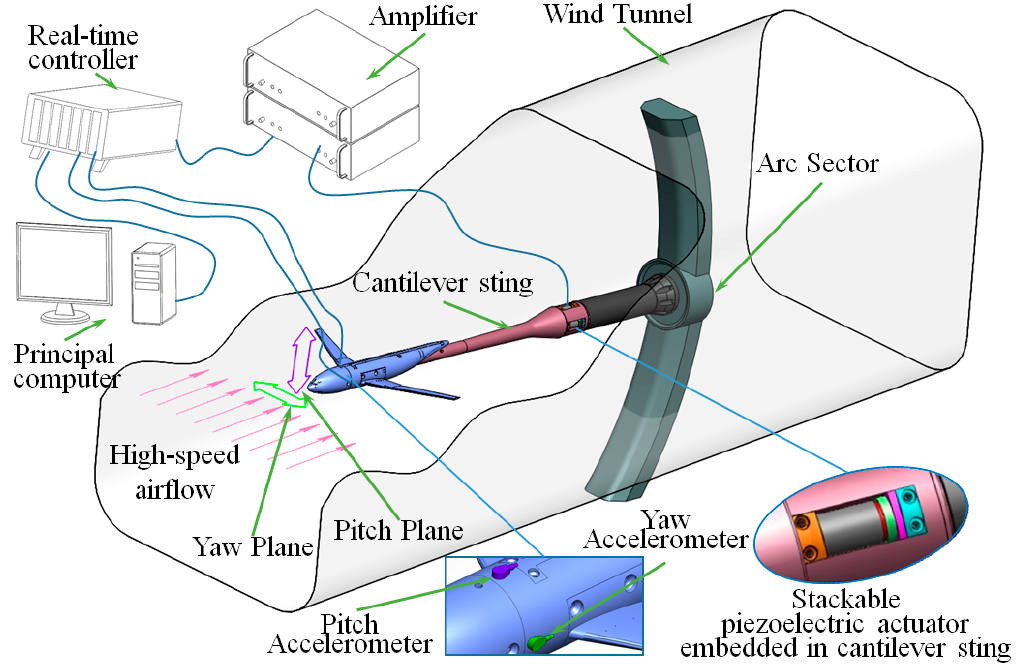
Figure 1. Schematic of multidimensional vibration suppression principle for wind tunnel models.